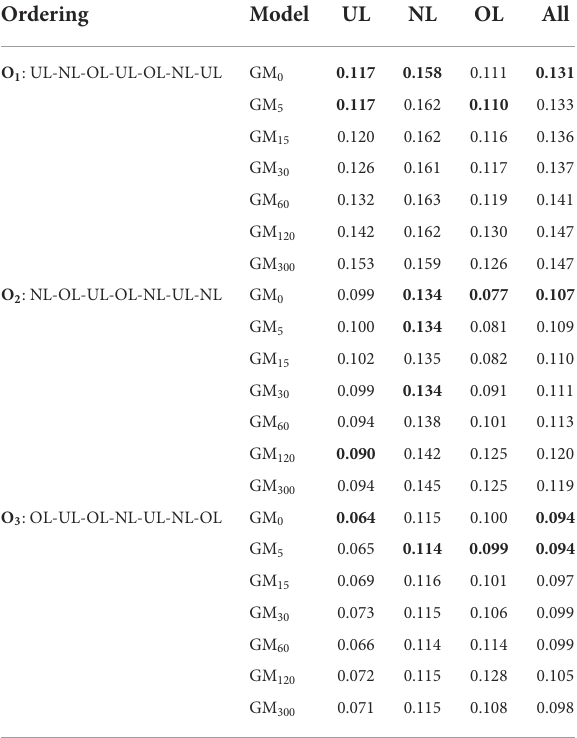
TABLE 2 The Pearson’s correlations between the predicted performance and actual performance for each generalized model by workload condition and each workload